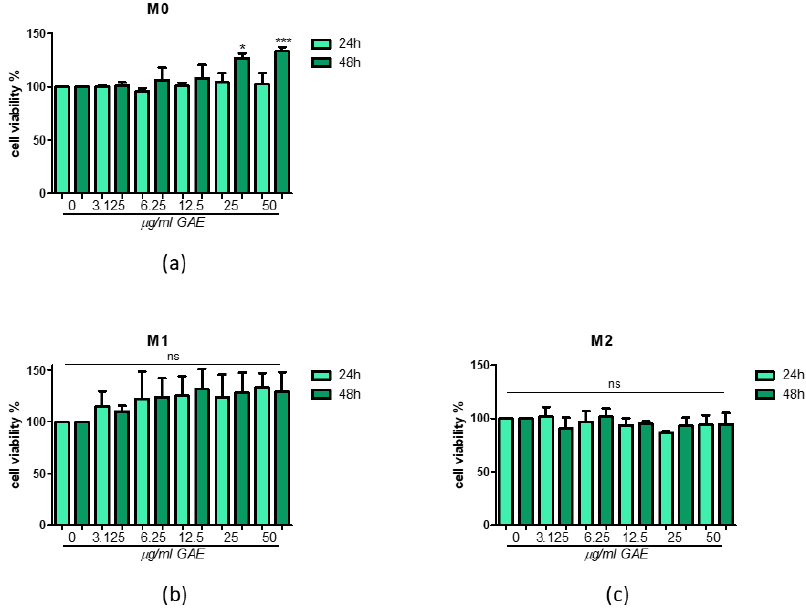
Figure 2. Cell viability after phenolic sumac extract treatment in M0 ( a ), M1 ( b ) and M2 ( c ). MTT assay was performed at 24 h and 48 h post-treatment. Cell viability was expressed as % of control (0 µ g/mL GAE). All data represent the means of at least 3 replicates ± standard deviation. The analysis of variance was carried out using the One-way ANOVA test followed by the Tukey’s Multiple Comparison Test; * p < 0.05, *** p < 0.001 were considered significant (untreated control vs. treated samples). GAE: gallic acid equivalents.